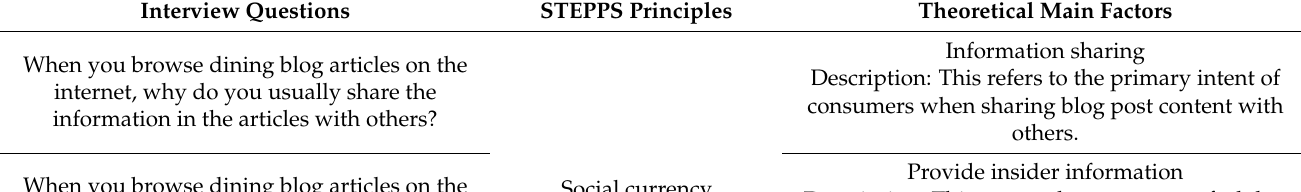
Table 1. Examples of mapping interview questions in the dining blog